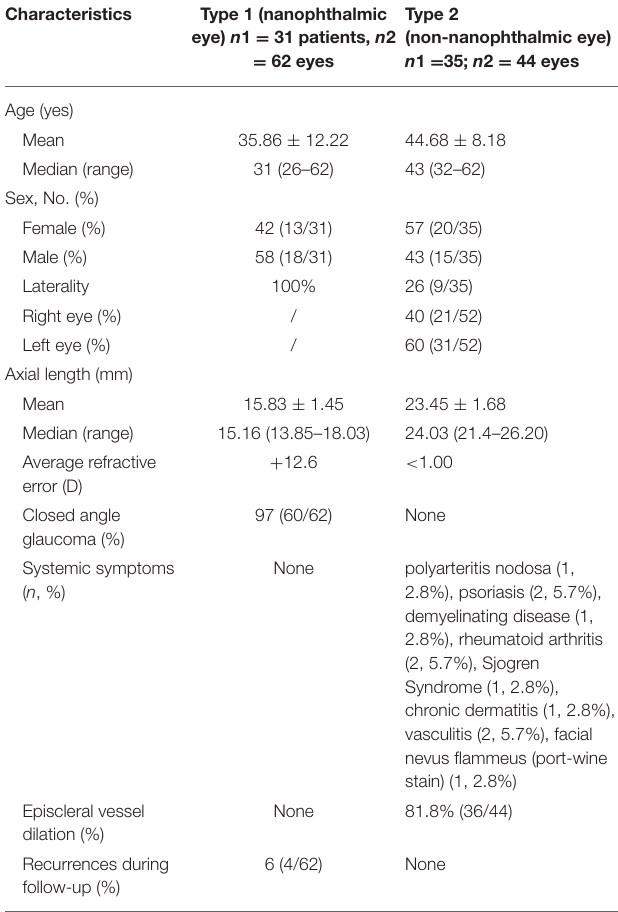
TABLE 1 | Descriptive characteristics of patients with UES of type 1 and type 2.